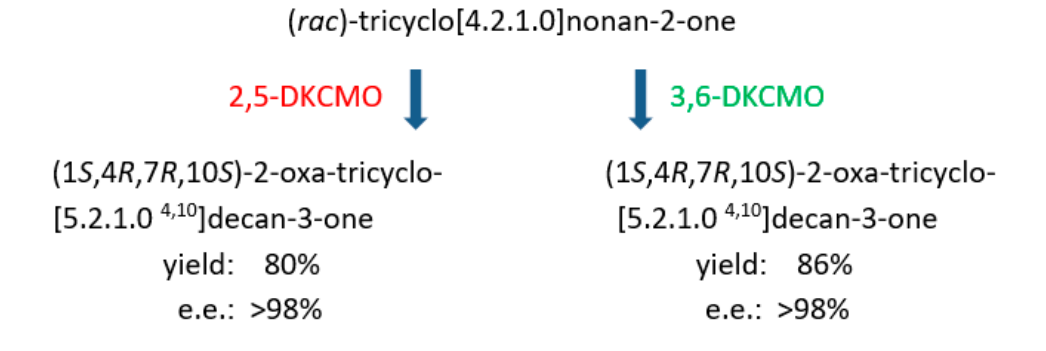
Figure 14. Biotransformation of the tricyclic ketone ( rac )-tricyclo[4.2.1.0]nonan-2-one by highly purified preparations of native 2,5-DKCMO and 3,6-DKCMO; e.e. = enantiomeric excess.